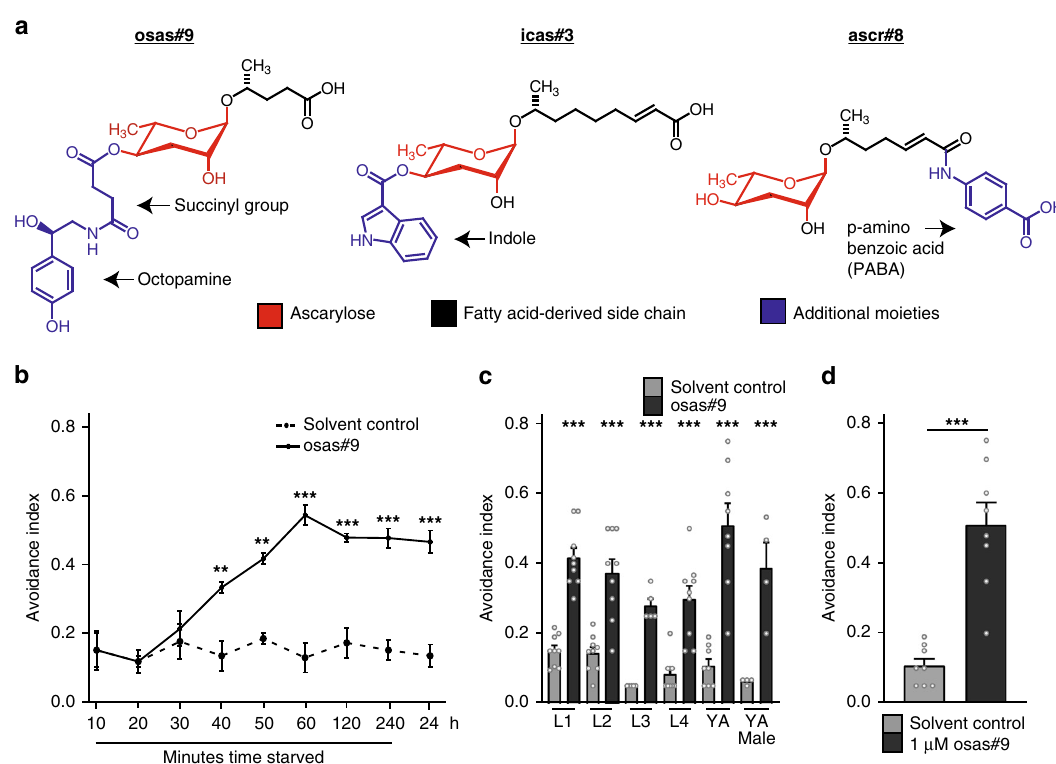
Fig. 1 osas#9 is repulsive to starved animals. a Structural and functional diversity of ascarosides. osas#9 is involved in avoidance, icas#3 attracts hermaphrodites, and ascr#8 attracts males at low concentrations and induces dauer formation at high concentrations. b Avoidance to osas#9 is dependent on the physiological state of C. elegans . Avoidance index of young adult (YA), wild type (N2) animals in response to solvent control (black dotted line), and 1 µ M osas#9 (black solid line) after different time points after removal from food. After 40 minutes of starvation, animals begin to avoid osas#9, with the response reaching a plateau at 60 min. n ≥ 3 trials. Note for all other assays, unless otherwise stated, animals are starved for at least 60 min. c All life stages of hermaphrodites, and adult males, avoid osas#9 when starved. n ≥ 4 trials. d Avoidance index for starved young adult (YA) wild-type worms in response 1 µ M osas#9. n = 8 trials. 1 µ M osas#9 concentration was used in all other assays unless stated otherwise. Data presented as mean ± S.E.M; * p < 0.05, ** p < 0.01, *** p < 0.001, one factor ANOVA with Sidak ’ s multiple comparison posttest, except for Fig. 1d, where a Student ’ s t -test was used. Individual data points for each bar graph are represented as gray tyra-2 is required in the ASH neurons for osas#9 sensation . To